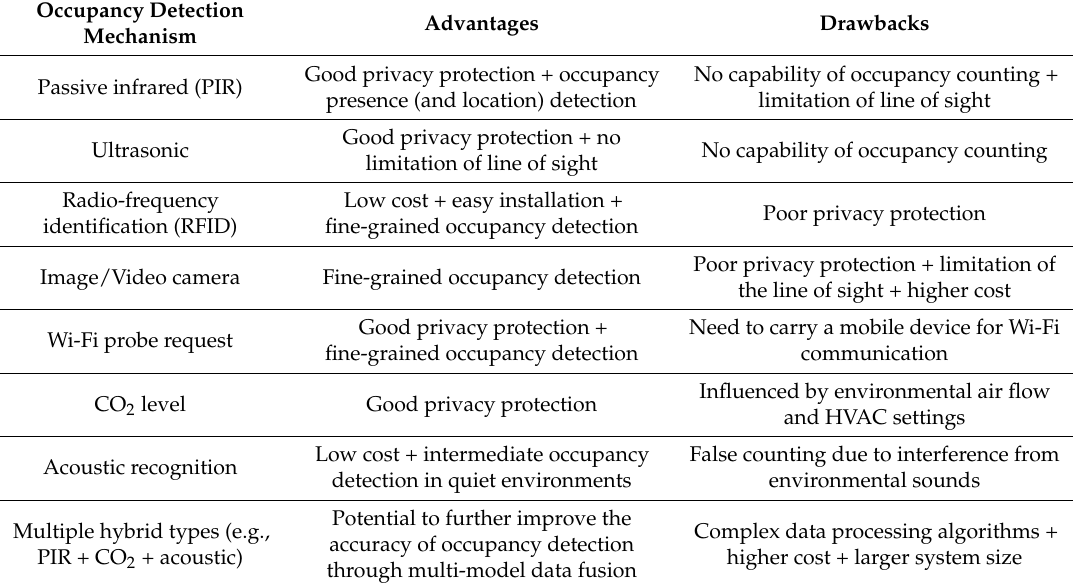
Table 1. Advantages and drawbacks of each existing occupancy-detection